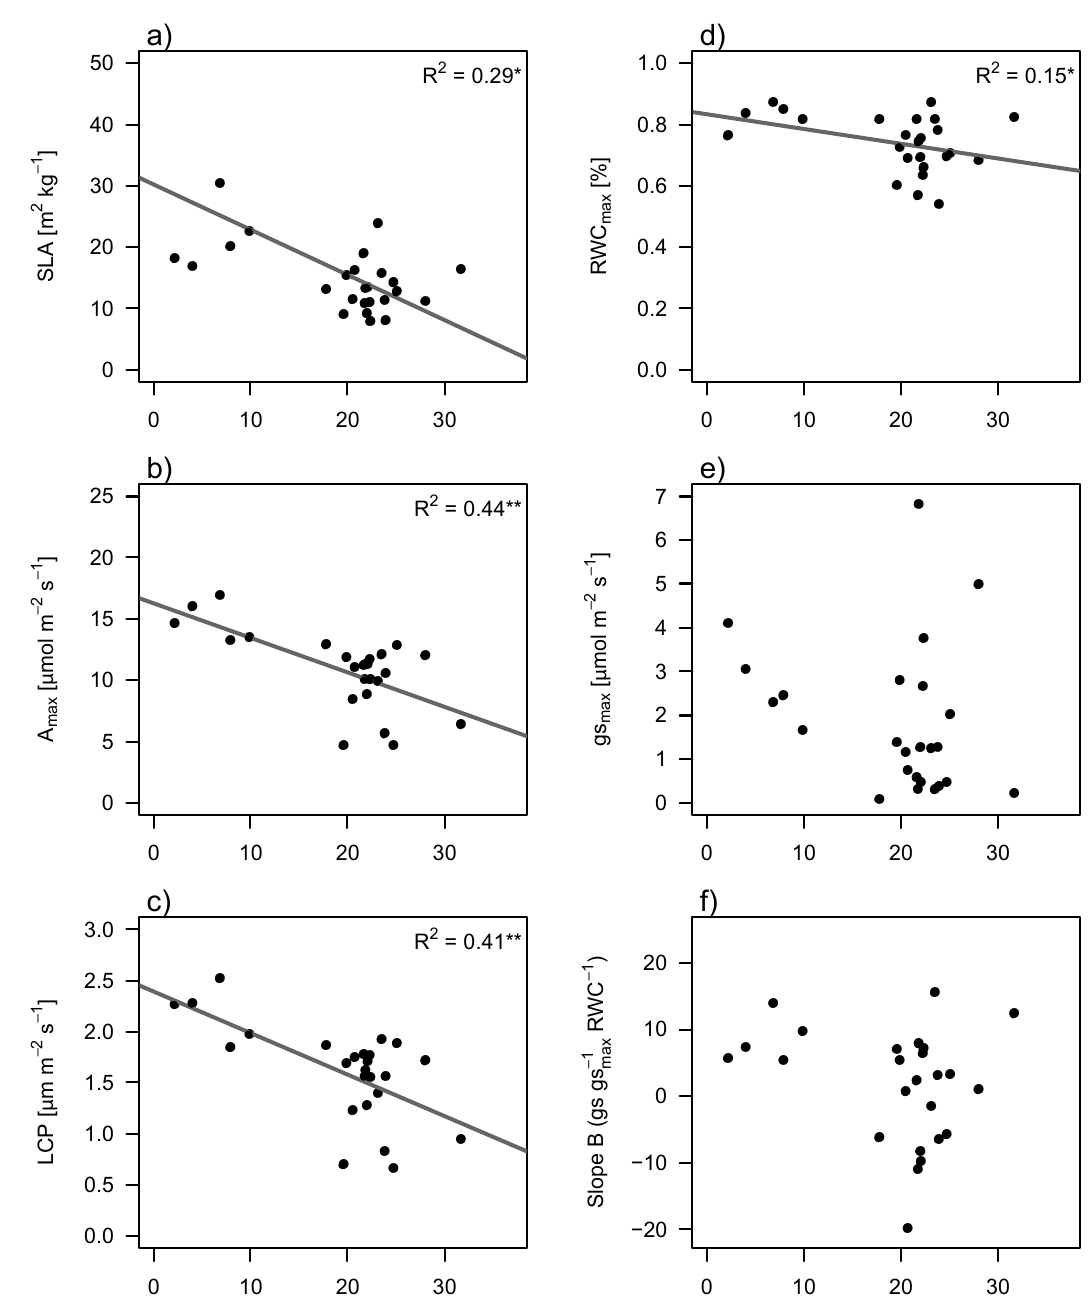
Figure 3. Changes in light related functional traits ( a – c ) and in water related functional traits ( d – f ) against species’ successional status. Species successional status was defined as the average stand basal area value at which a species was most abundant. Abbreviations are SLA, specific leaf area; RWC max , relative water content of a fully hydrated leaf; A max , photosynthetic rate; g smax , maximum stomatal conductance; LCP, light compensation point; Slope B; slope of drought response curve ((g s /g smax )/RWC). A steeper slope indicates lower drought tolerance. Solid lines show significant regression and are indicated with R 2